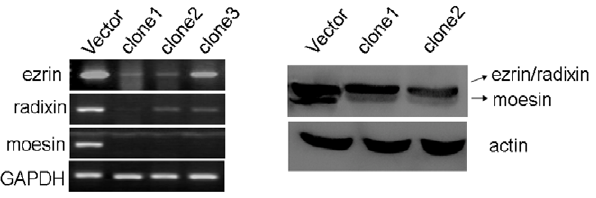
Figure 5. Effects of ERM-shRNA on ERM expression. MOLT4 cells were transfected with ERM-shRNAs and cells were selected in G418 (200 m g/ml) for 2 weeks. After 6–8 weeks with G418 selection, the clones were selected for identification by RT-PCR and Western